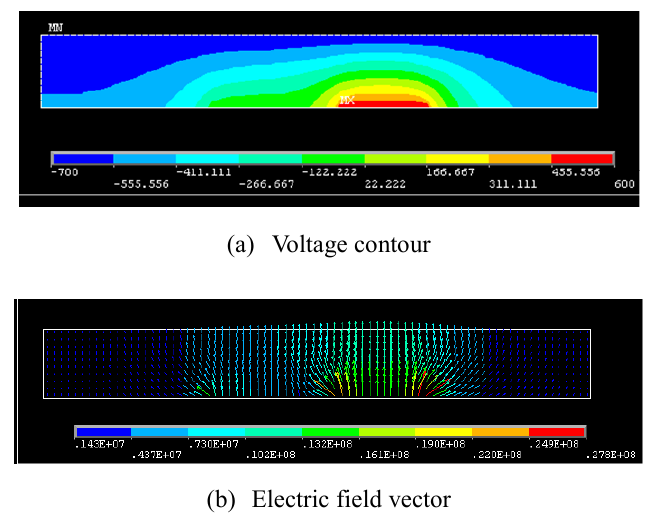
Fig. 18 Voltage contour and electric field vector around one electrode